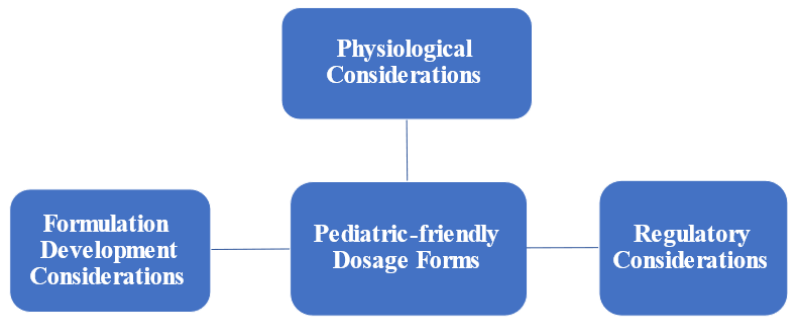
Figure 1. Challenges associated with developing pediatric-friendly dosage forms.